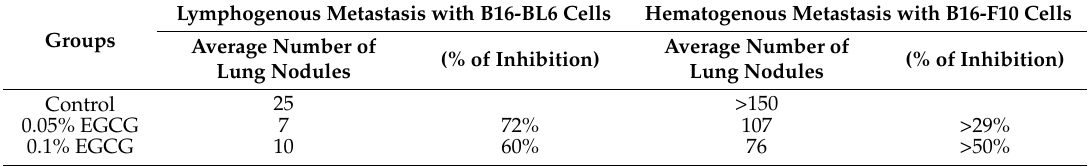
Table 1. Inhibition of lung metastasis of B16 melanoma cells by oral administration of EGCG